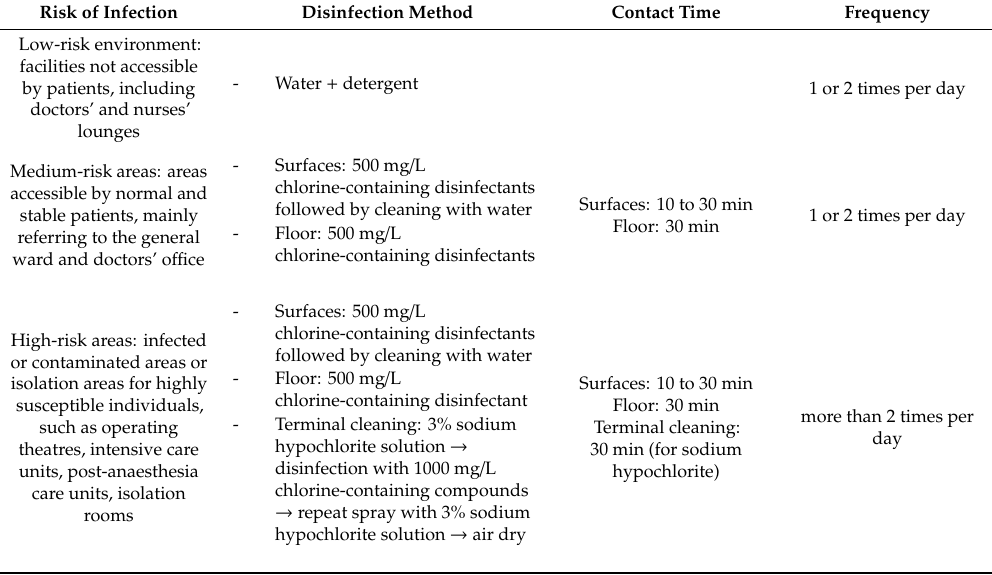
Table 3. Cleaning and disinfection policy and practice for di ff erent levels of risk areas of Oral and Maxillofacial Surgery Unit against SARS-CoV-2 (WST-512-2016 Guidance of Environmental and Surfaces Cleaning, Disinfection and Infection Control in Hospitals)